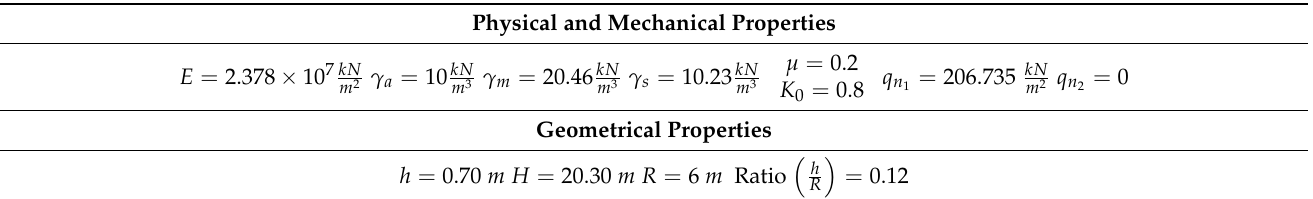
Table 3. Physical, mechanical and geometrical properties of the tunnel ventilation shaft N°1 of the project-“Río La Com- pañia” from Espejel.